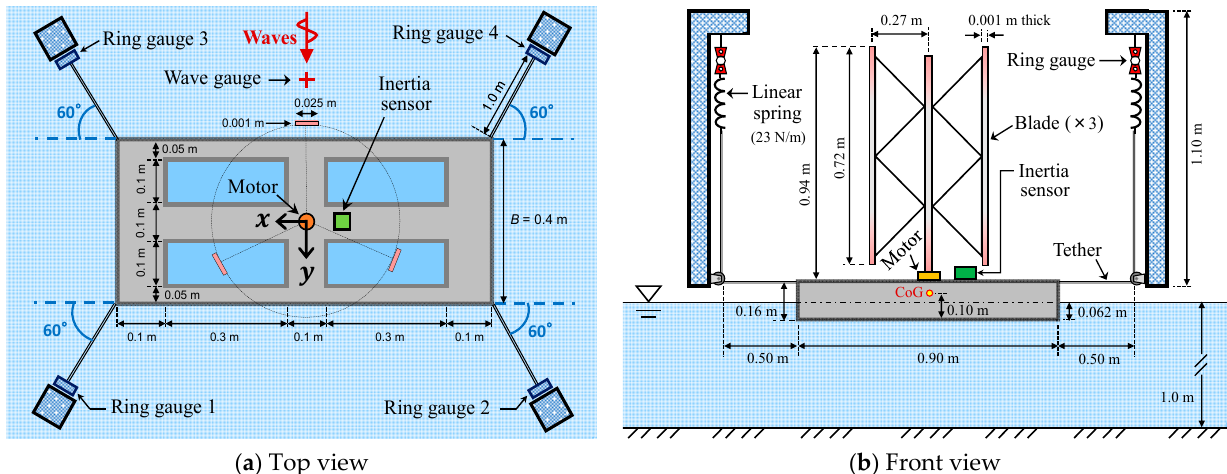
Figure 3. Sketch of the setup of physical model tests. (Adapted from Ikoma et al. (2021) [26]). Table 1. Experimental variables.